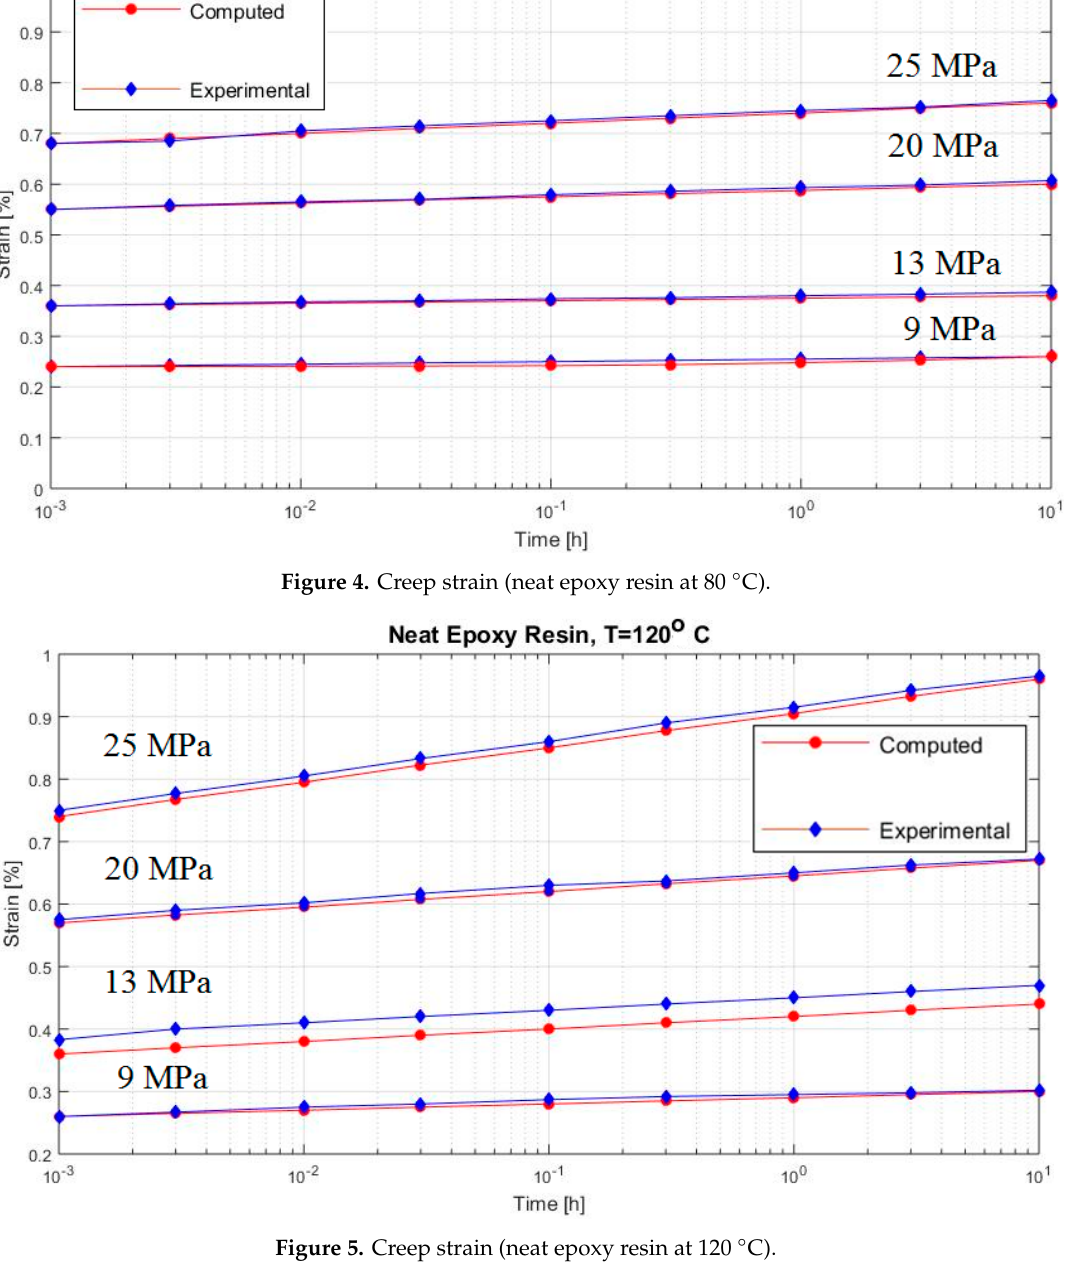
Figure 5. Creep strain (neat epoxy resin at 120 °C).